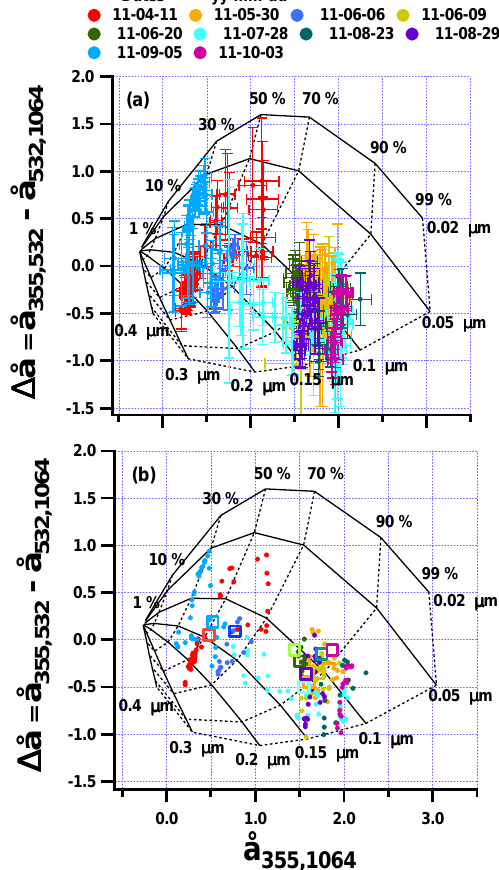
Fig. 15. (a) Scatter plot of 1 å (z) vs. å 355 , 1064 (z) with correspond- ing uncertainties retrieved from the lidar measurements performed on ten measurement days (Table 2). Different colours are used to represent different measurement days. (b) Scatter plot of 1 å (z) vs. å 355 , 1064 (z) mean values without corresponding uncertainties. The open boxes represent the 1 å in and å in (355, 1064) data point for each measurement